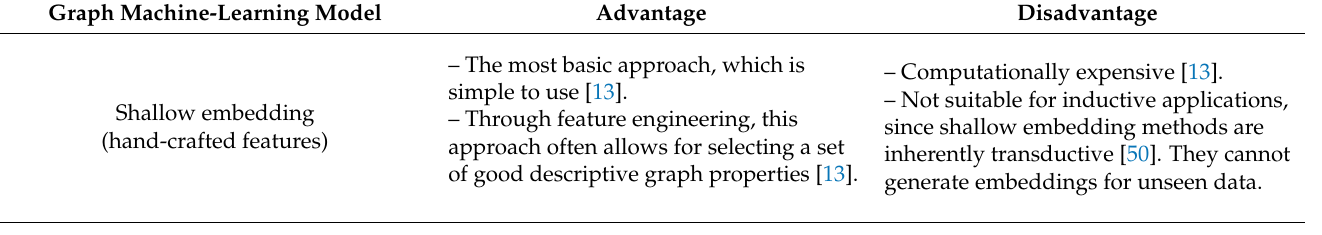
Table 2. The advantage and limitations of different types of graph machine-learning